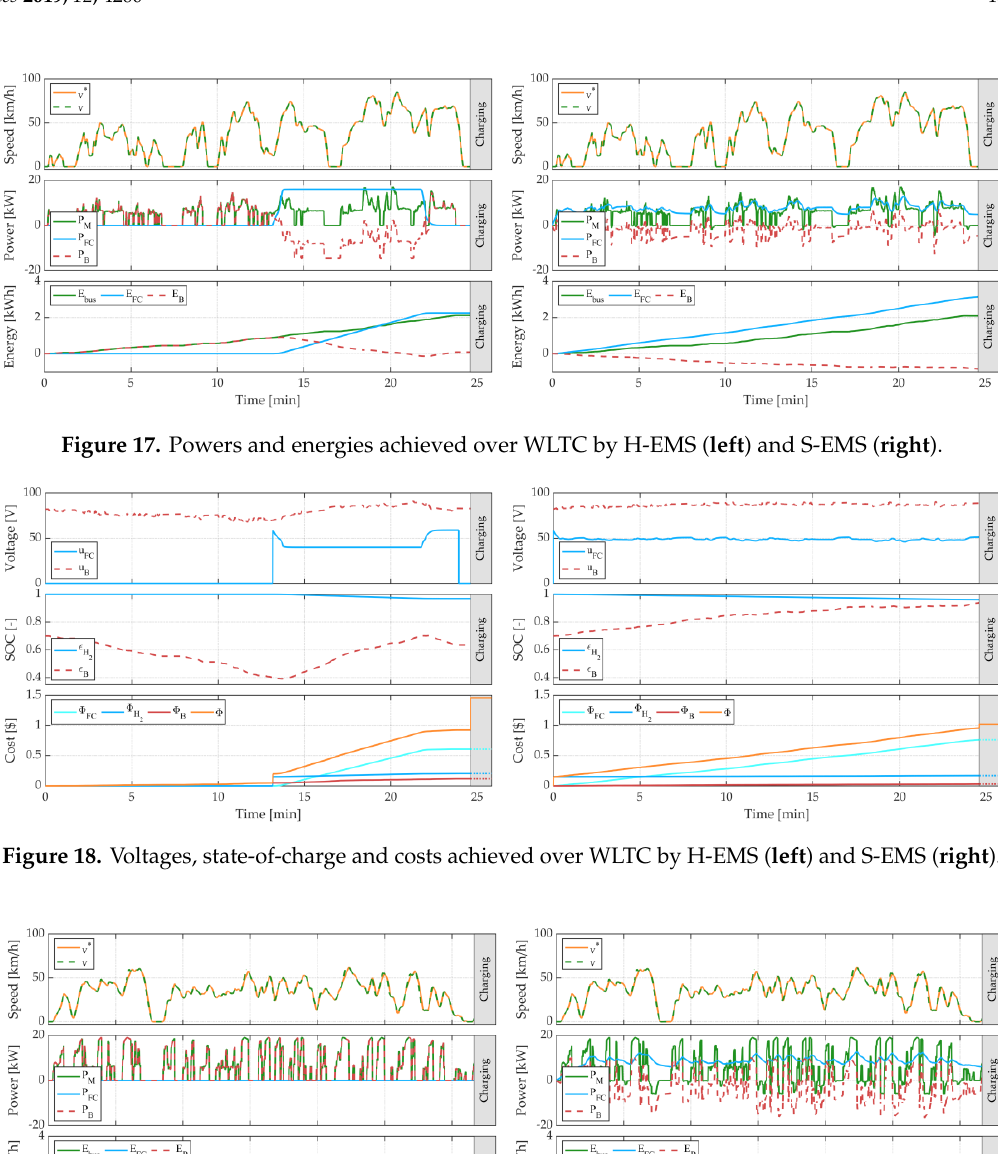
Figure 16. Voltages, state-of-charge and costs achieved over NEDC by H-EMS ( left ) and S-EMS ( right ).